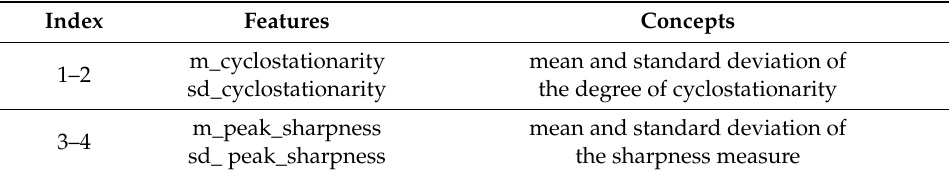
Table A5. The summary of the features in Cyclostationary domain.